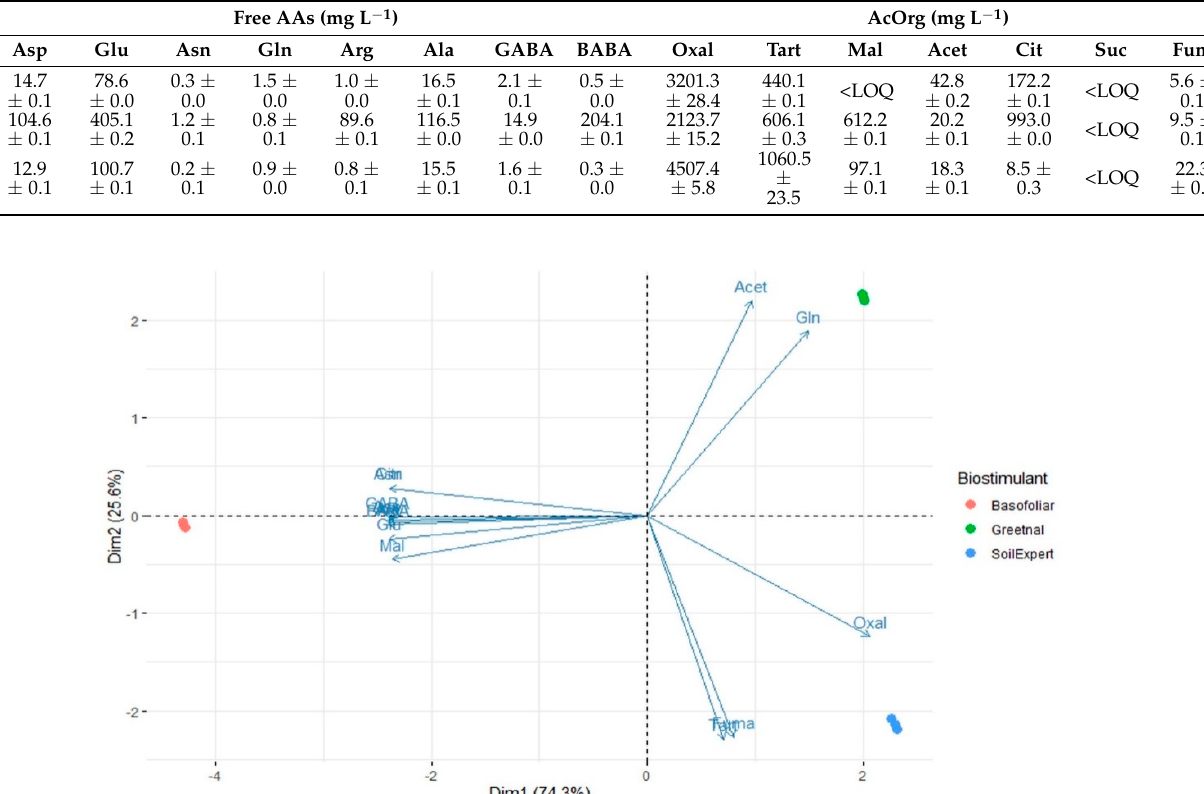
Table 2. Content of free AAs (mg L − 1 ) and AcOrg (mg L − 1 ) in three commercial biostimulants ((Greetnal (GT), Basofoliar (BF), or SoilExpert (ST)). Average ± standard error (SE). Free AAs (mg L − 1 )